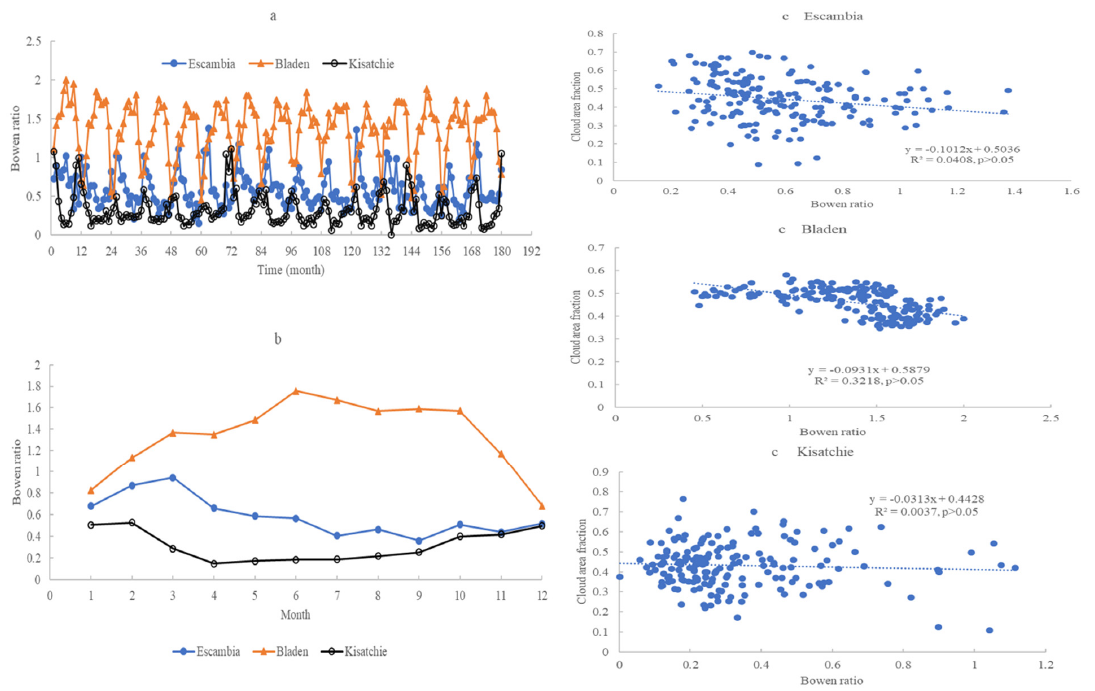
Figure 12. Dynamics of Bowen ratio in the three areas. ( a ) Monthly and yearly Bowen ratio in the three areas from January 2000. ( b ) The integrated monthly average of Bowen ratio. ( c ) The relation- ship between Bowen ratio and total cloud area fraction in the three areas.